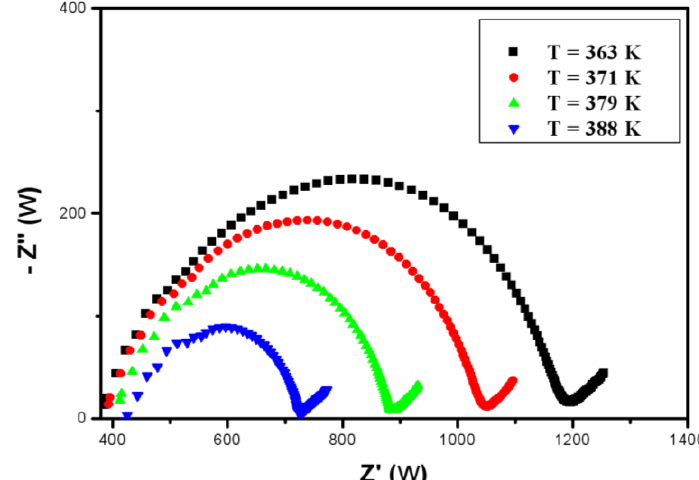
Figure 5. Typical impedance spectra of [3-(CH